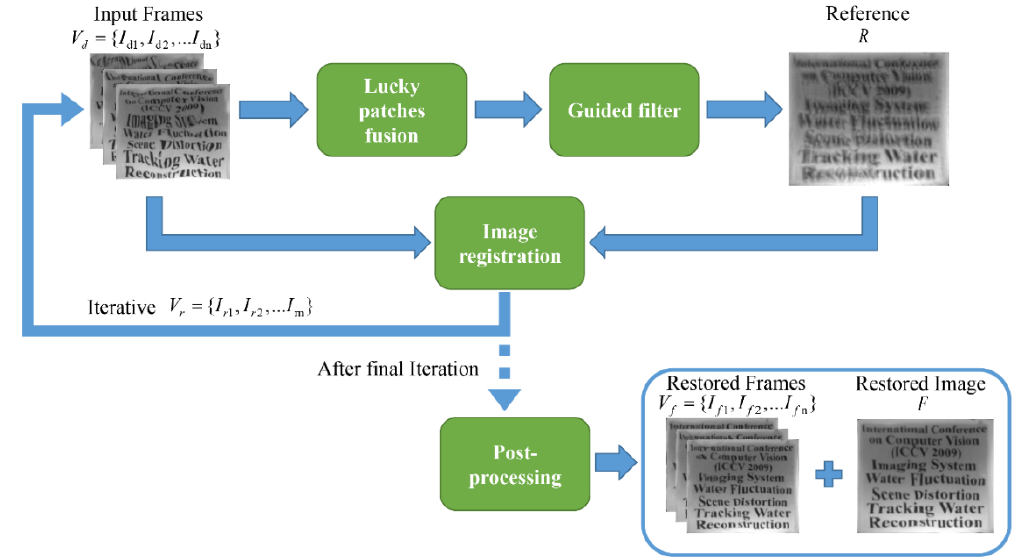
Figure 1. Simple flow diagram of the proposed method.